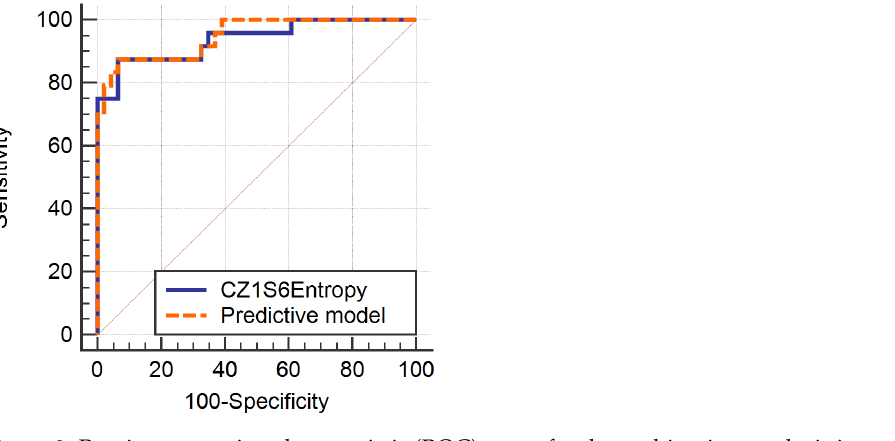
Figure 2. Receiver operating characteristic (ROC) curve for the multivariate analysis in metastatic lymph node detection compared to CZ1S6Entropy.